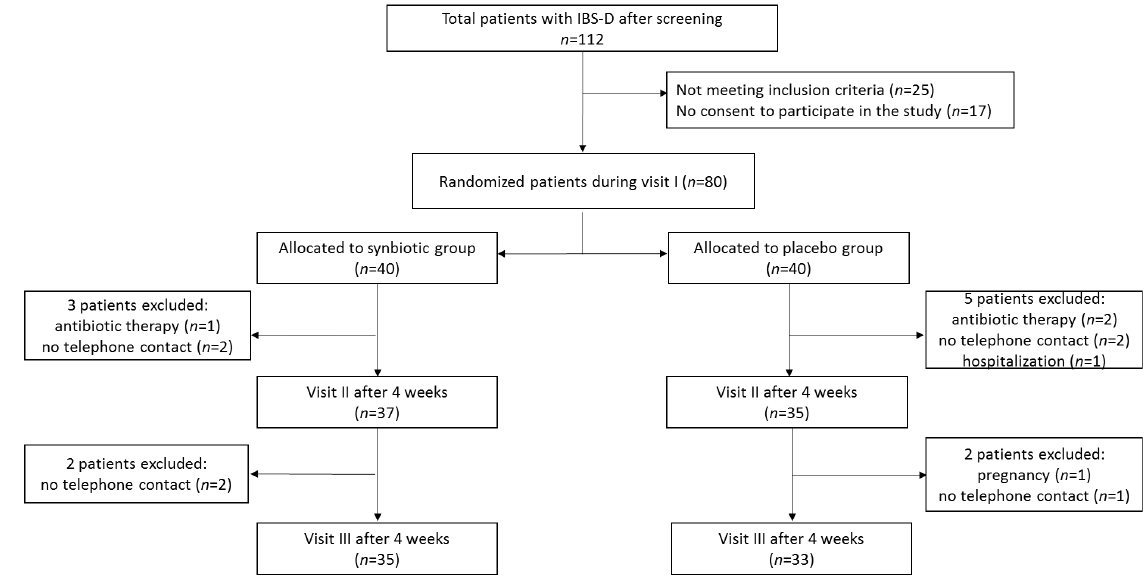
Figure 1. The flowchart of study protocol.